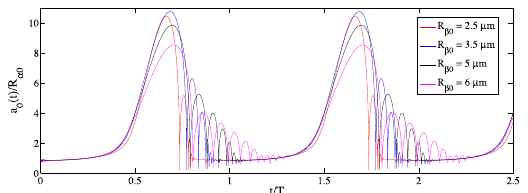
Figure 4. Temporal evolution of a 0 ( t ) for different initial radii of bubble b ( T = 50 l s, R a 0 = 4.5 l m).